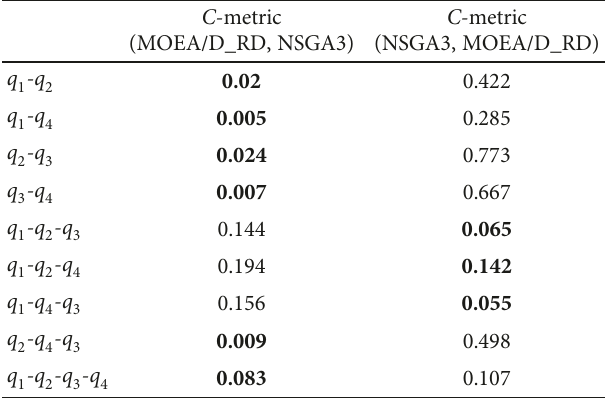
Table 10: IGD-metric of the compared four algorithms. Table 7: Comparison of C -metric of MOEA/D_RD and